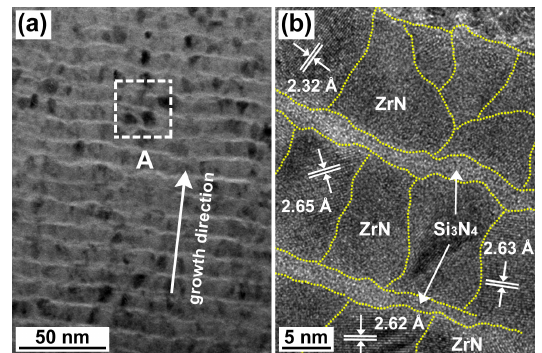
Figure 2. ( a ) The cross-sectional TEM image of the ZrN/Si 3 N 4 multilayer coating; ( b ) shows a HRTEM (high resolution transmission electron microscopy) image of framed region A.